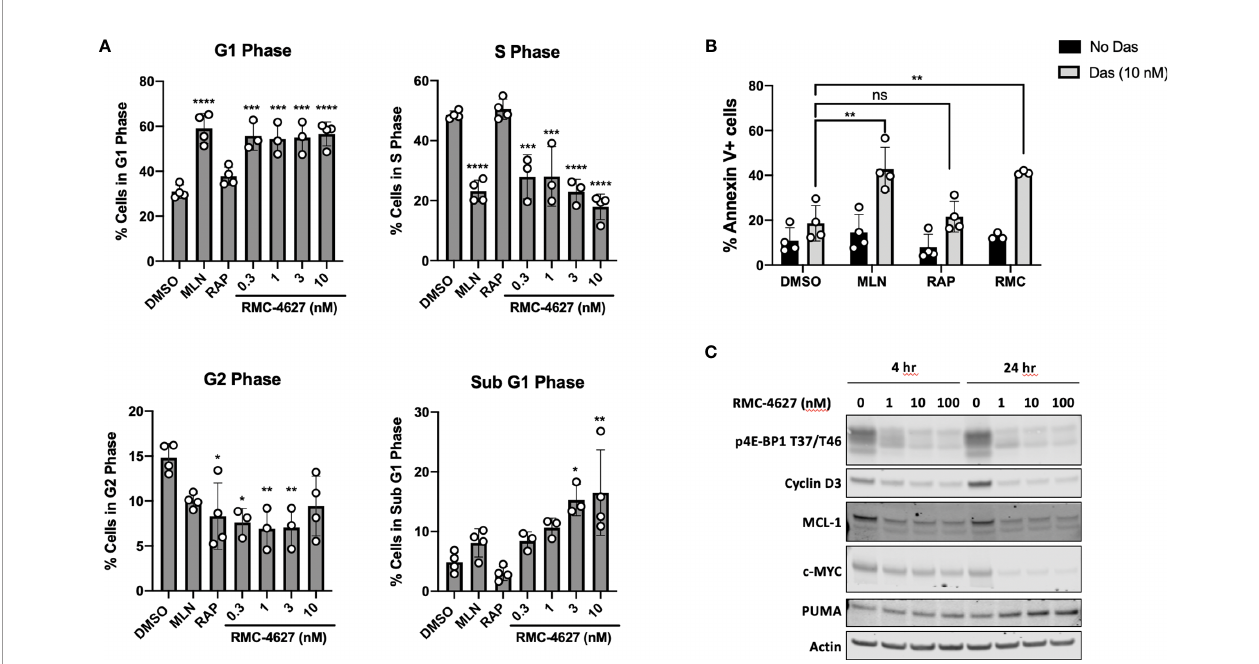
FIGURE 2 | RMC-4627 decreases viability of human B-ALL cells as a single agent and in combination with dasatinib. (A) Propidium iodide staining and cell cycle analysis of SUP-B15 cells following incubation with the indicated compounds for 48 hours (MLN: MLN0128, 100 nM; RAP: rapamycin, 10 nM). Data are expressed as percent of cells in each phase, and are the mean of n=4 experiments with error bars representing SD. Statistical test: ordinary one-way analysis of variance (ANOVA) with post-hoc Tukey ’ s multiple comparison test (See Supplementary Table 1 for exact P values and corresponding *, **, ***, and **** annotations). (B) Annexin V staining of SUP-B15 cells following incubation with MLN (MLN0128, 100 nM), RAP (rapamycin, 10 nM), and RMC-4627 (1 nM) in the absence or presence of dasatinib (10 nM) for 48 hours. Data are the mean of n=3 or 4 experiments with error bars representing SD. Statistical test: ordinary one-way analysis of variance (ANOVA) with post-hoc Tukey ’ s multiple comparison test (** P = 0.0011 for DMSO+Das and MLN+Das; ns P = 1.0 for DMSO+Das and RAP+Das; ** P = 0.0053 for DMSO+Das and RMC+Das). (C) Immunoblot analysis of cell lysates from SUP-B15 cells starved for 24 hours in 0.1% FBS, then incubated with the indicated concentrations of RMC-4627 for 4 and 24 hours in the presence of 10% FBS. Data are a representative of three experiments with similar